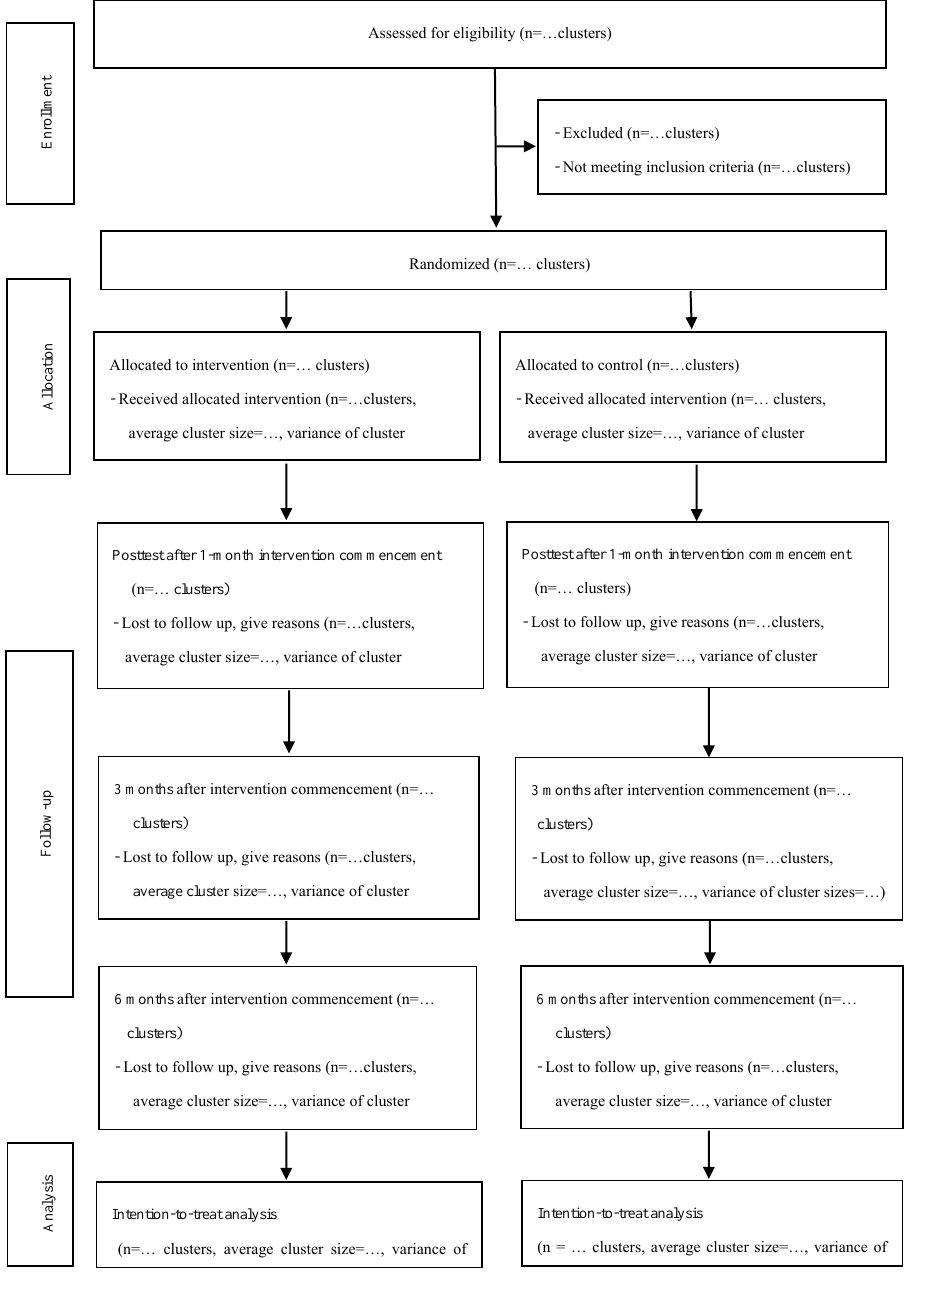
Figure 1. CONSORT flow diagram of the study—adapted from Campbell et al. [37].